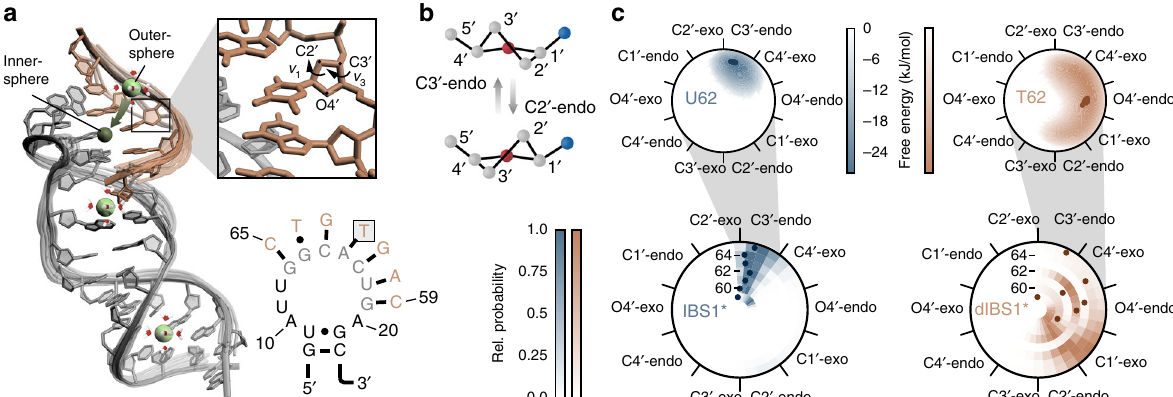
Fig. 4 Sugar pucker distributions from all-atom MD simulations. a NMR structure of EBS1*/dIBS1* (PDB: 2m1v 34 ) with overlaid backbones of the 18 lowest energy structures. Outer-sphere binding sites based on NOE restraints from dIBS1* protons (i.e., H3 and CH 3 of T62/64 and H5/6 of C65) to [Co (NH 3 ) 6 ] 3 + (large green spheres; H 2 O molecules are added for clarity) and a potential inner-sphere coordination mode where Mg 2 + binds further inside the tunnel (smaller dark green sphere) 35 . b Switch between energetically favored sugar pucker conformations C3 ′ -endo and C2 ′ -endo. c Circular histogram of pseudorotation angles along the seven nucleotides of IBS1* or dIBS1* (C59 – C65) from MD simulations with 100 mM K + and 20 mM Mg 2 + . Insets show distribution of pucker phases and amplitudes of U62 and T62. Puckers of the lowest energy NMR structures and their medians are indicated as dots for each residue. Source data are provided as a Source Data fi Our FRET trajectories capture binding and unbinding events